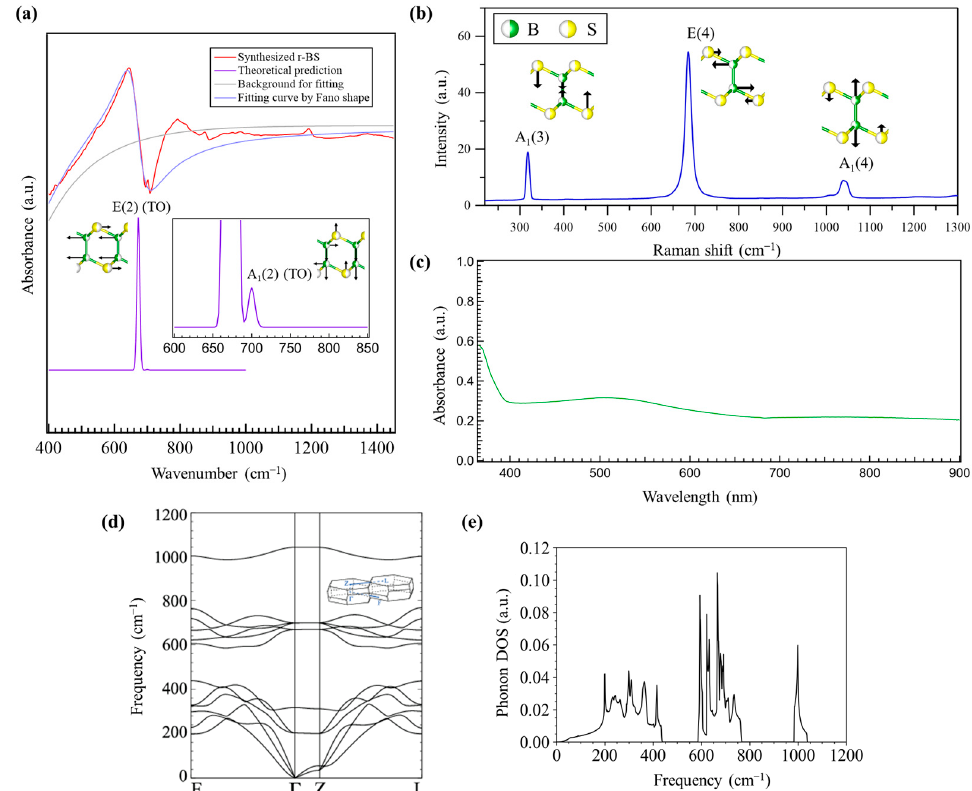
Figure 2. Optical properties of the synthesized r-BS powder. ( a ) Fourier transform infrared absorption spectra with fitting by Fano shapes and theoretical predictions of the E(2) (TO) and A1(2) (TO) phonon modes. ( b ) Raman scattering and ( c ) Ultraviolet-Visible absorption spectra. r-BS calculated phonon dispersion ( d ) and density of states (DOS) ( e ) of r-BS. The k -point path in the rhombohedral Brillouin zone is shown in the inset in panel